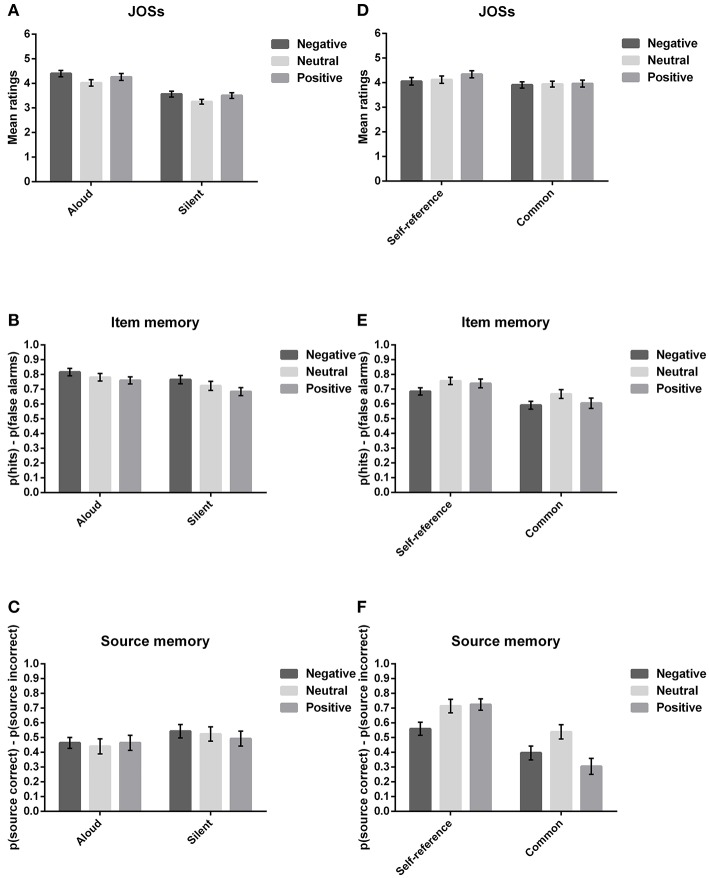
Behavioral results for JOSs, item memory and source memory in Experiments 1 and 2. Specifically, the behavioral results for judgments of source (JOSs; A,D), item memory (B,E), and source memory (C,F) are plotted on the y-axis as a function of source (aloud/silence; self-reference/common) and valence (negative/neutral/positive). Note: The error bars indicate the standard errors of the means.